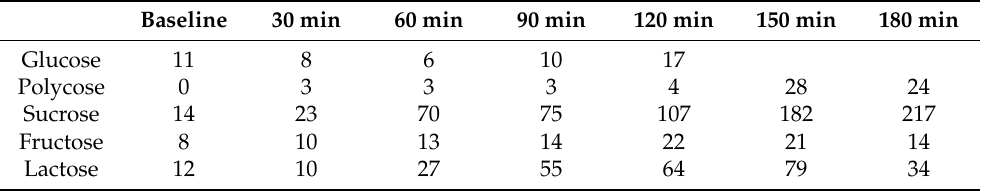
Table 1. Extensive carbohydrate malabsorption documented by hydrogen breath testing (measured in parts per million).